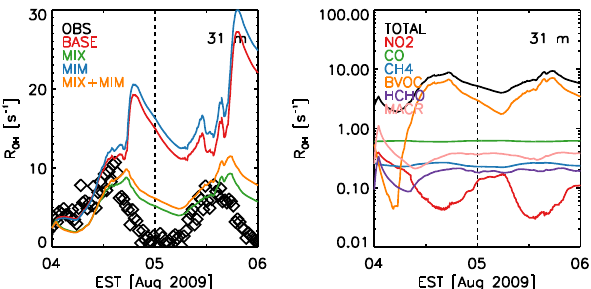
Fig. 12. Total OH reactivity measured (OBS) and modeled (BASE, MIX, MIM, and MIX+MIM) at 30.9m for 4–5 August 2009 (left); modeled total OH reactivity and from speciated contributions of NO 2 , CO, CH 4 , BVOC (ISO+API+LIM), HCHO, and MACR for the MIX case